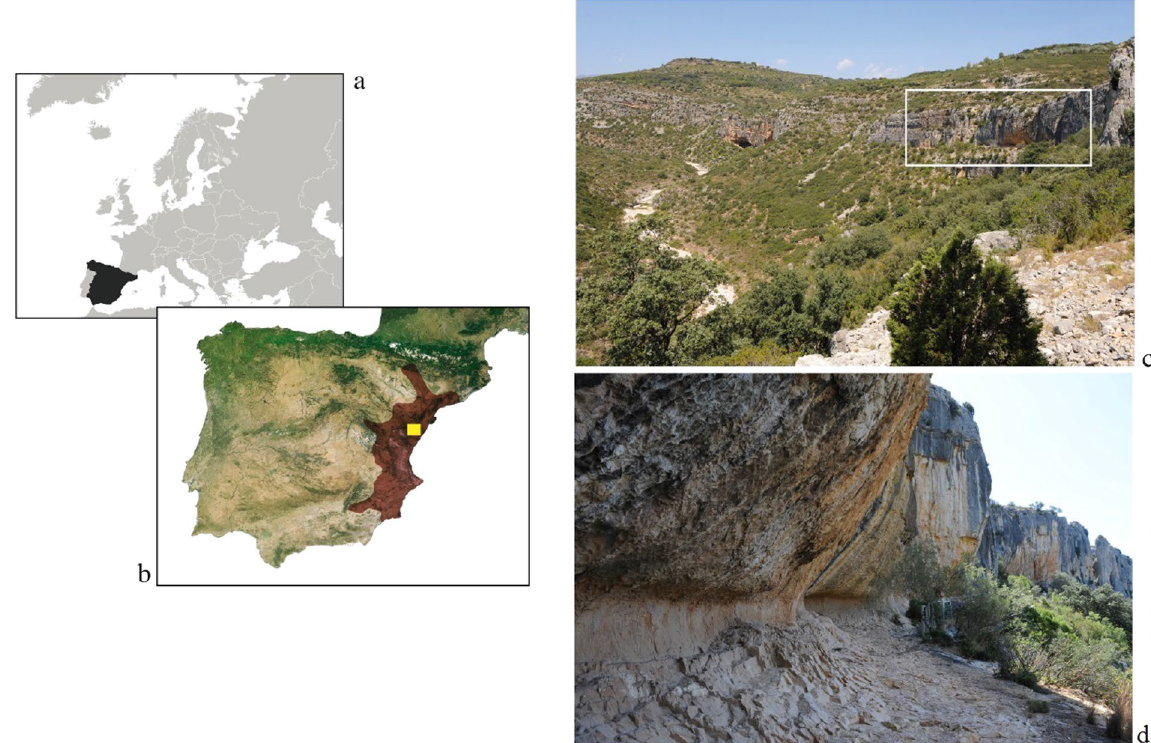
Figure 1. ( a ) Geographic location of the La Saltadora shelter (Coves de Vinromà, Castellón, Spain * ). ( b ) The geographic zone of influence of Spanish Levantine rock art is shown in red ** . ( c ) The location of La